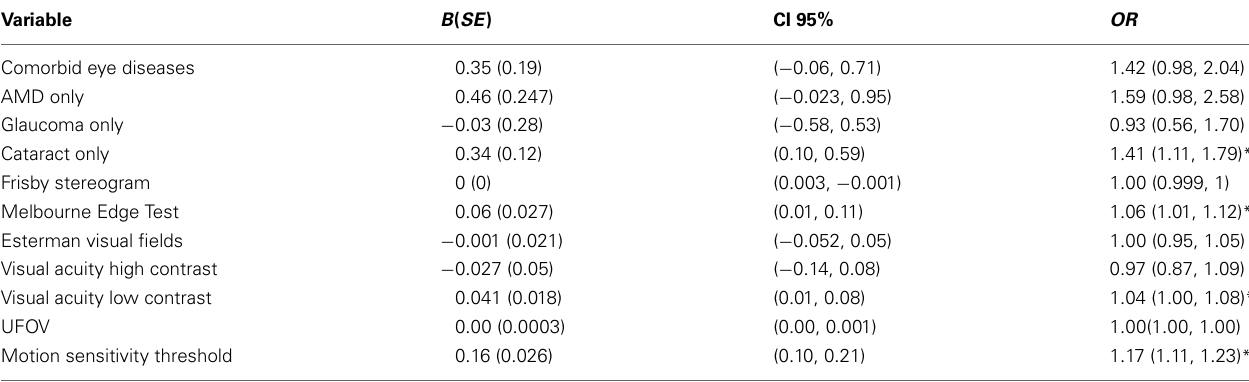
Table 3 | Association between eye disease and visual function and anxiety symptoms. Variable